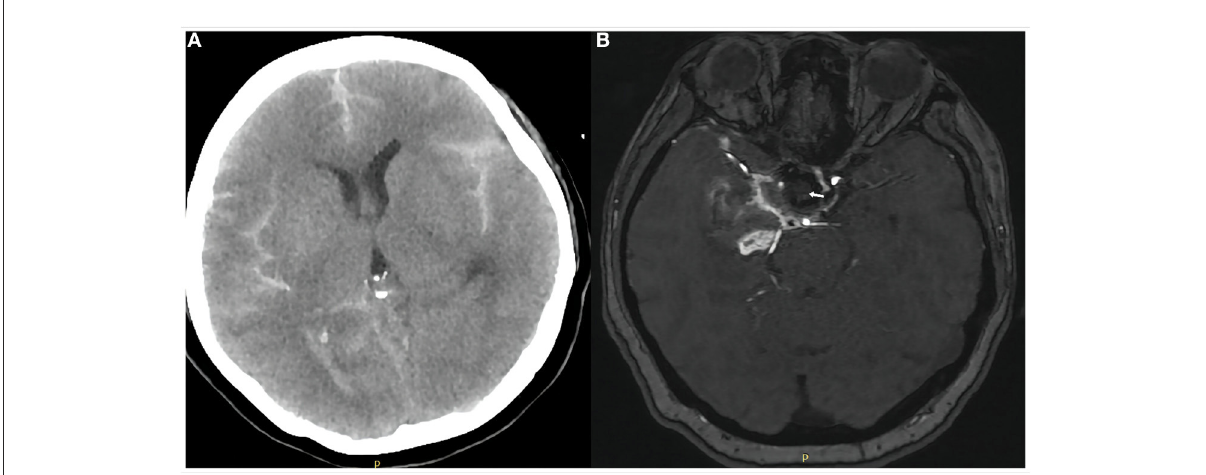
FIGURE4 Computed tomography of the head on day 1 after covered stent placement (A) showed no progression of subarachnoid hemorrhage or other obvious abnormality. Magnetic resonance angiography of the brain on day 6 (B) showed the aneurysm was completely occluded (white arrow) and the parent artery was